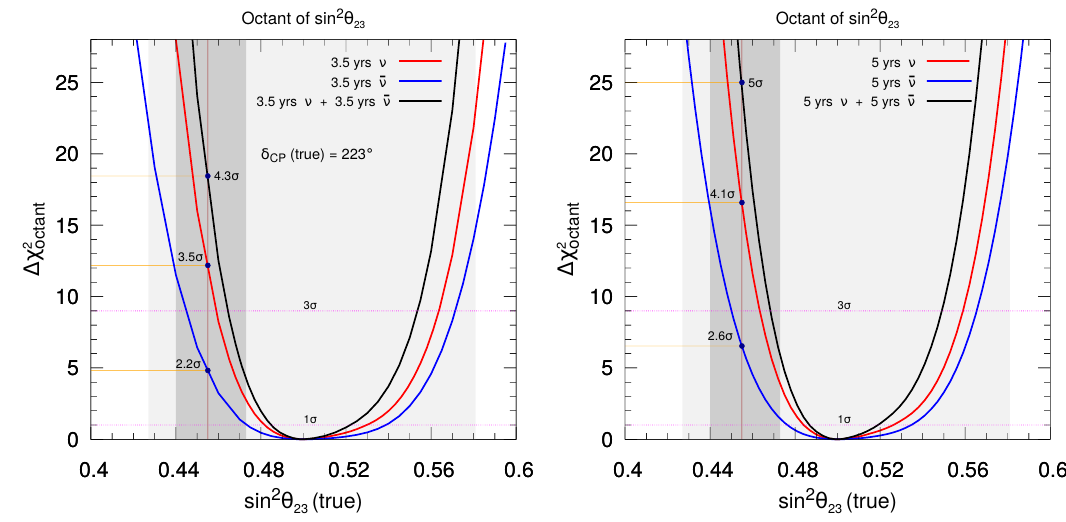
Figure 11 . Octant discovery potential of DUNE as a function of true sin 2 θ 23 assuming true NMO and δ (true) = 223 ◦ . The red, blue, and black curves in the left (right) panel are drawn assuming CP 3.5 (5) years of neutrino run, 3.5 (5) years of antineutrino run, and the combined 7 (10) years of and δ , while ν + ¯ ν run, respectively. In the fit, we marginalize over the current 3 σ range of ∆ m 2 CP 31 keeping rest of the oscillation parameters fixed at their present best-fit values as shown in table 1. The dark (light)-shaded grey area shows the currently allowed 1 σ (2 σ ) region in sin 2 θ as obtained 23 in the global fit study [11] assuming NMO with the best-fit value of sin 2 θ = 0 . 455 as shown by 23 vertical brown line. The horizontal orange lines show the sensitivity (experessed in σ = p ∆ χ 2 ) octant due to individual runs for the current best-fit value of sin 2 θ . The octant discovery potential at 1 σ 23 ( ∆ χ 2 = 1 ) and 3 σ ( ∆ χ 2 = 9 ) confidence levels are shown by horizontal pink dotted octant octant